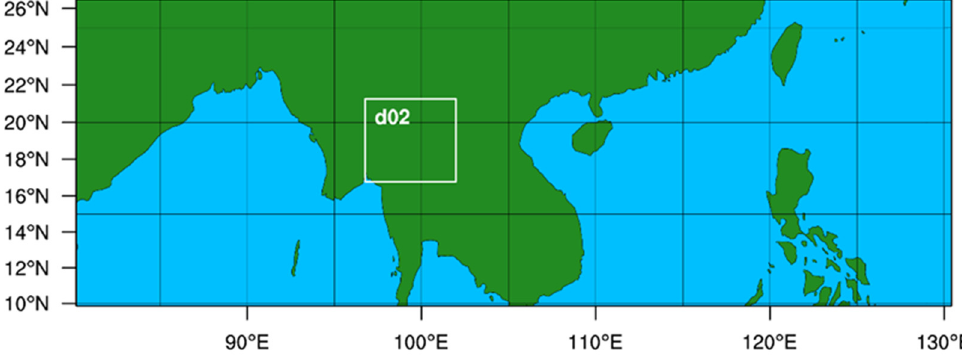
Figure 2. WRF domain configuration.